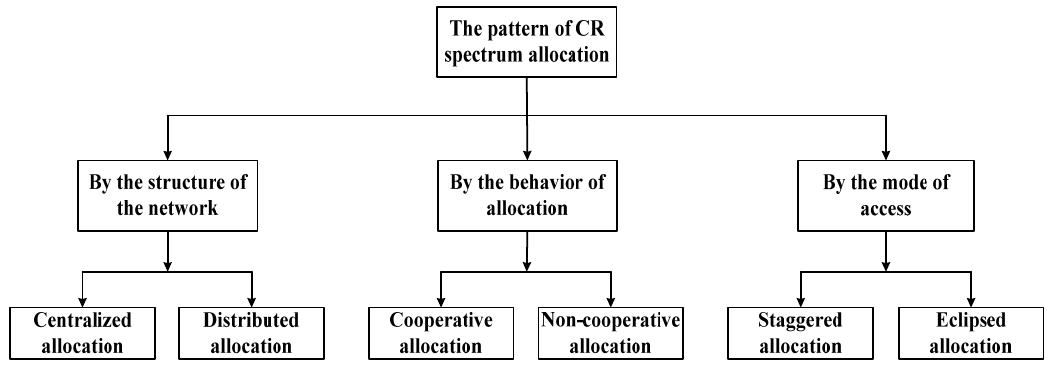
Figure 2. Three categories of cognitive radio (CR) spectrum allocation